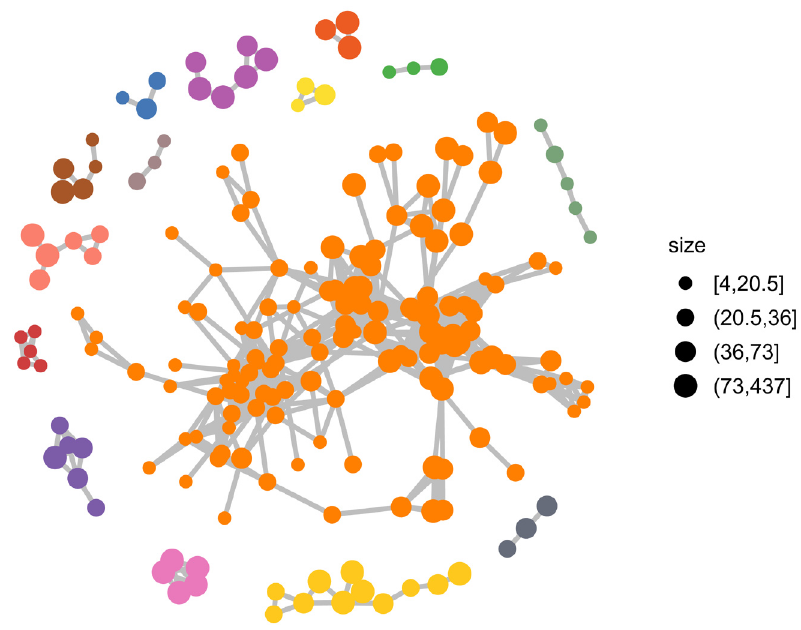
Figure 3. Gene set network with singletons and binary clusters removed. Colored according to disjoint